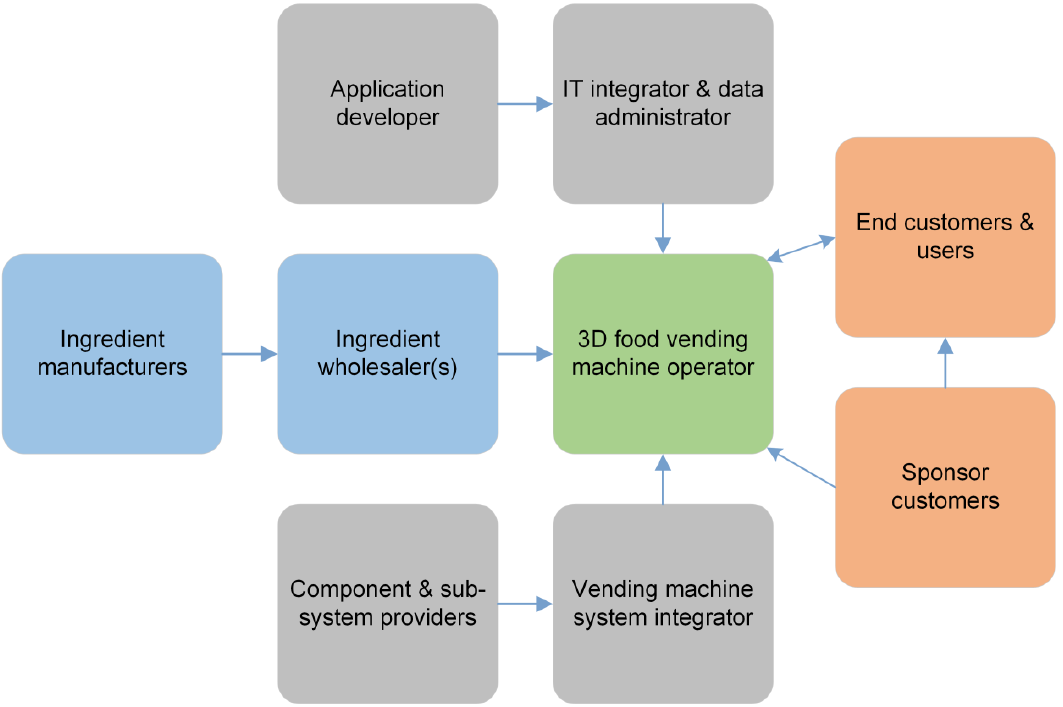
Figure 9. Value chain of business model—Personalized